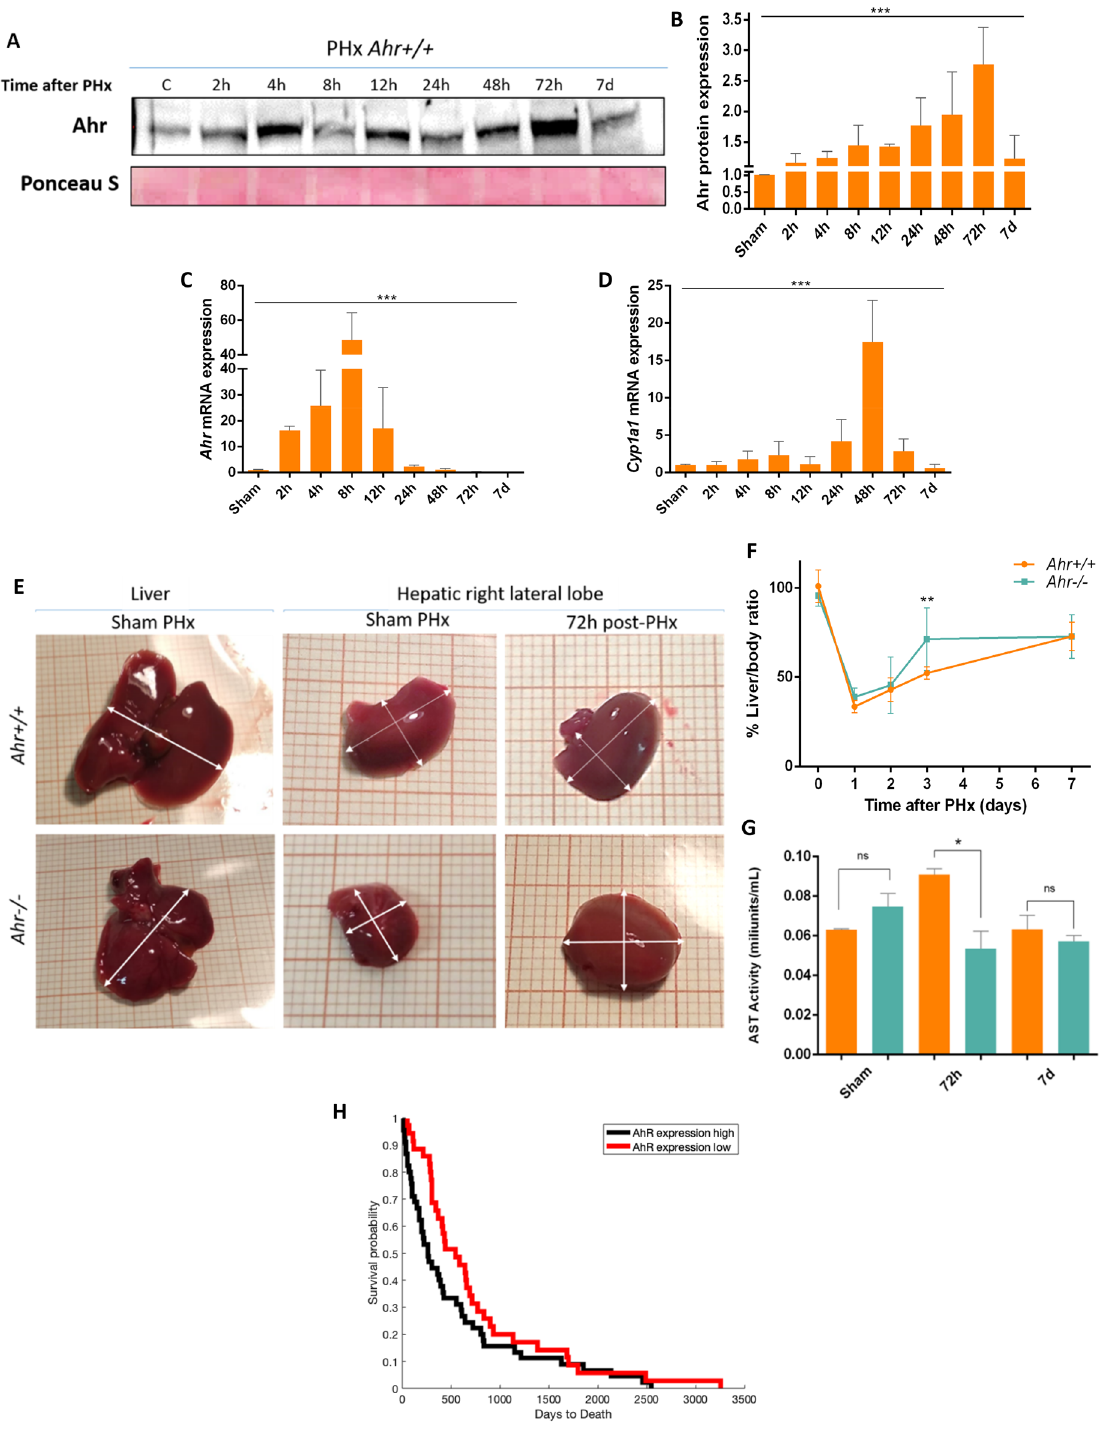
Figure 1. Ahr is induced and activated in the liver after PHx. ( A , B ) Protein expression of Ahr was analyzed in liver extracts of AhR + / + mice at the indicated time points after PHx by immunoblotting. Ponceau staining was used to normalize protein levels. ( C , D ) Profiles of Ahr mRNA expression ( C ) and of its transcriptional targets Cyp1a1 ( D ) and Cyp1b1 in AhR + / + mice at the indicated time points after PHx using RT-qPCR . Gapdh levels were used to normalize target gene expression (ΔCt) and 2 −ΔΔCt to calculate changes in mRNA levels with respect to sham-surgery wild type mice. Oligonucleotides and antibodies used are indicated in Supplementary Tables 1 and 3, respectively. ( E ) Lack of Ahr increases liver regeneration after PHx. Representative images of Ahr + / + and Ahr −/− livers before (left) and 72 h after 2/3 PHx (right); sham operated mice are shown by comparison (middle). ( F ) Regeneration was quantified as the percentage of liver vs total mouse weight. ( G ) AST activity were measured using serum samples from the same mice and under the same experimental conditions. ( H ) Kaplan–Meier survival of human patients with hepatocarcinoma after resection surgery according to Ahr expression. **p < 0.01, ***p < 0.001. Data are shown as mean ± SD. The experiments were performed using six ( E , F ) or three ( A – D , G ) mice for each genotype and three technical replicates were